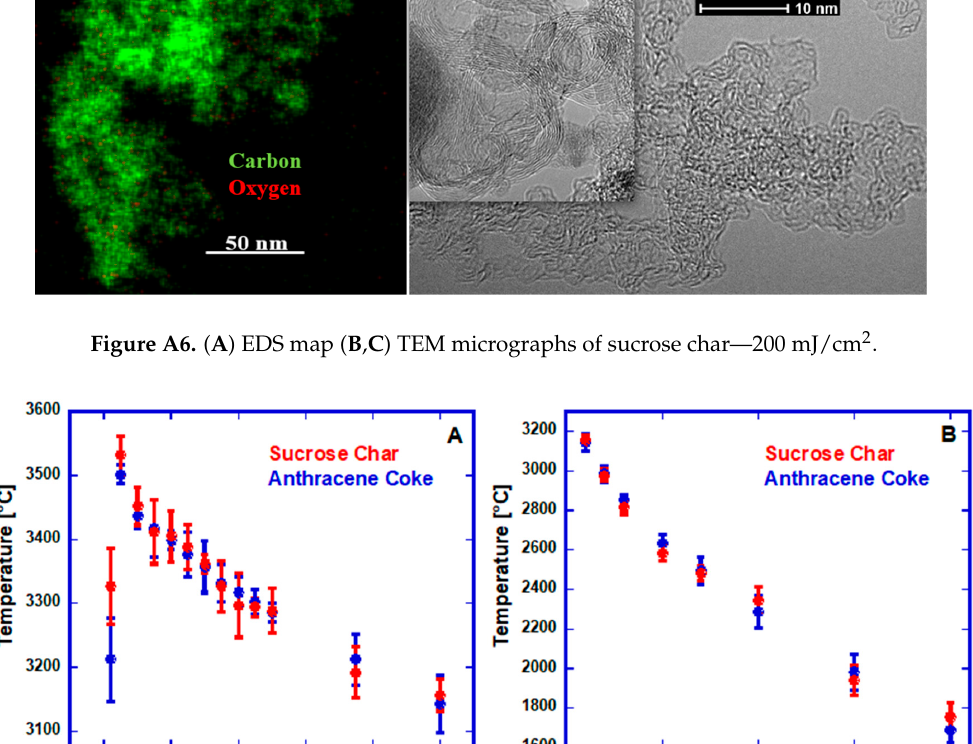
Figure A7. TTHs of sucrose char and anthracene coke—100 mJ/cm 2 —( A ) first 100 ns ( B ) post 100 ns.